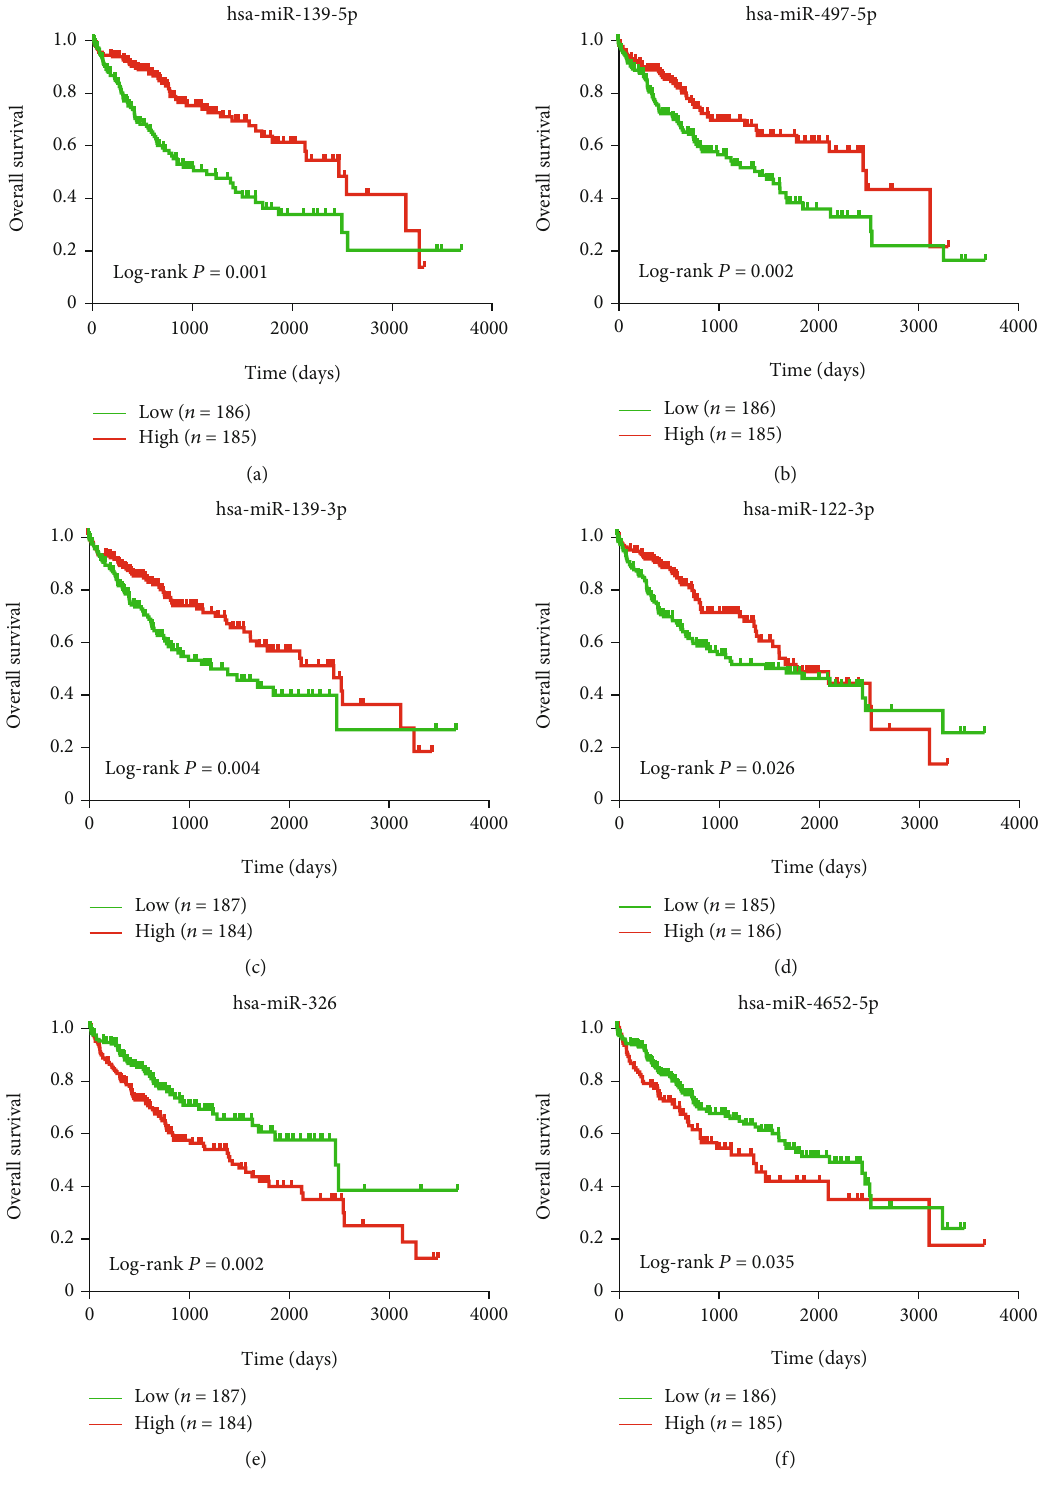
Figure 3: Six of the top 20 DEGs associated with the prognosis of HCC patients. Overall survival (OS) of the top 20 DEGs was evaluated by the Kaplan-Meier curves, and di ff erences between survival rates were examined using the log-rank